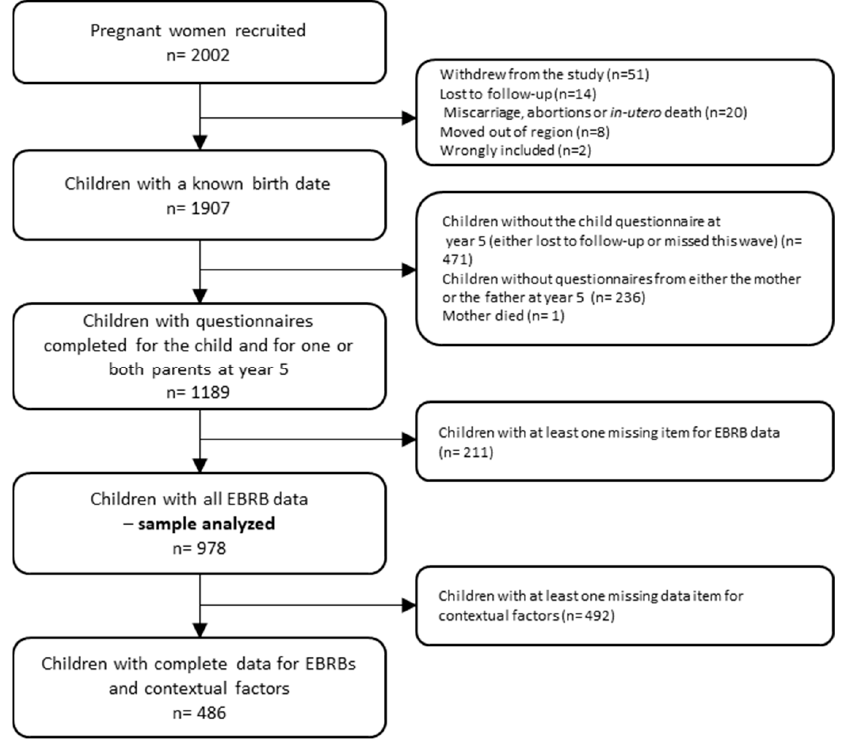
Figure 2. Flow chart of the population included in the study. The EDEN study. EBRBs: Energy balance ‐ related behaviors.